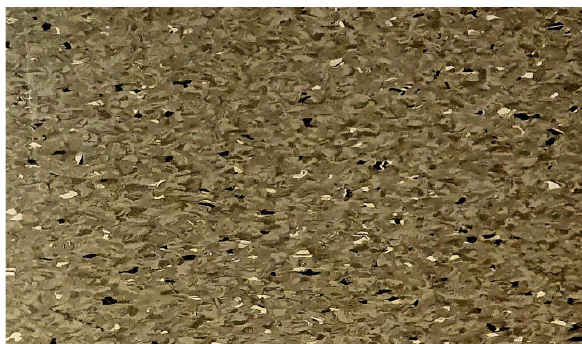
Figure 10. Floor pattern; Floor Patch